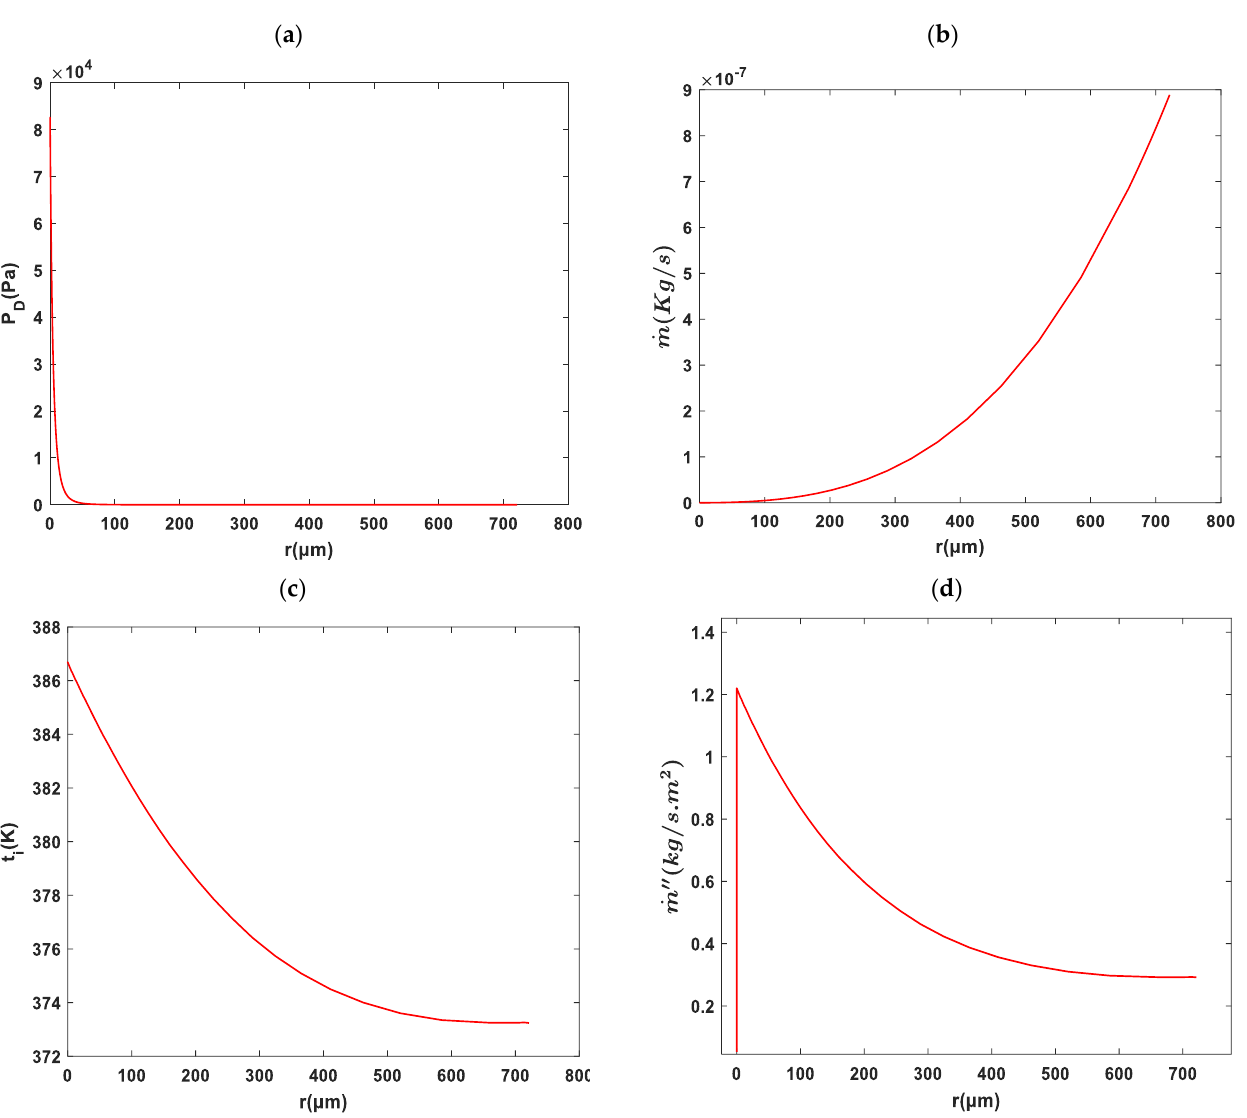
Figure 6. Radius evolutions of ( a ) disjoining pressure; ( b ) mass flow rate; ( c ) interfacial temperature; and ( d ) evaporation mass flux for baseline parameters at a time step of 3.9 ms.